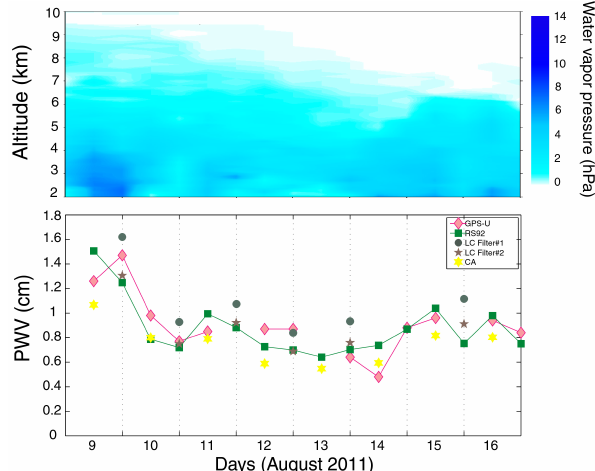
Fig. 5 : Daily evolution of PWV (cm) obtained in August at daytime ( ∼ 11:15 UTC) and night- Fig. 5. Daily evolution of PWV (cm) obtained in August at daytime time ( ∼ 23:15 UTC) using CA and LC, as well as GPS-U and RS92. In the upper panel is ( ∼ 11:15UTC) and nighttime ( ∼ 23:15UTC) using CA and LC, as presented the vertical daily evolution of water vapor pressure (hPa) during this period obtained well as GPS-U and RS92. In the upper panel is presented the verti- from radiosonde data. cal daily evolution of water vapor pressure (hPa) during this period obtained from radiosonde data.